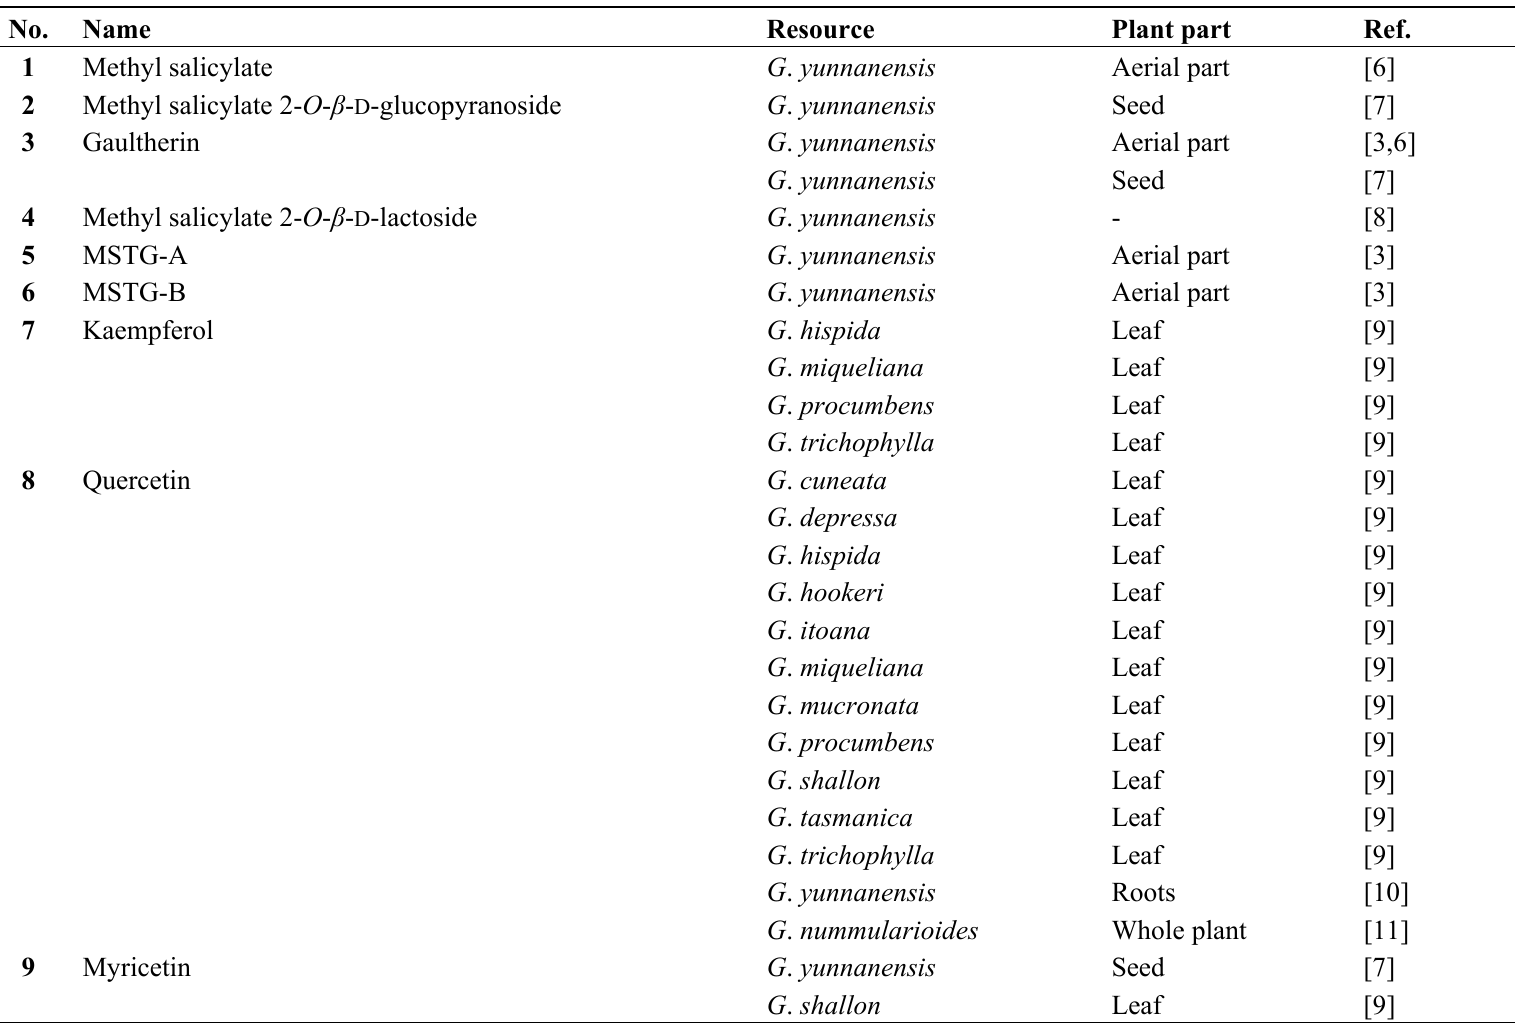
Table 1. Chemical Constituents from Genus Gaultheria